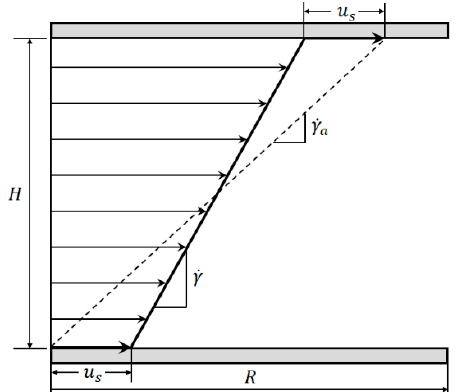
. γ . γ in the velocity profile a and true shear rate